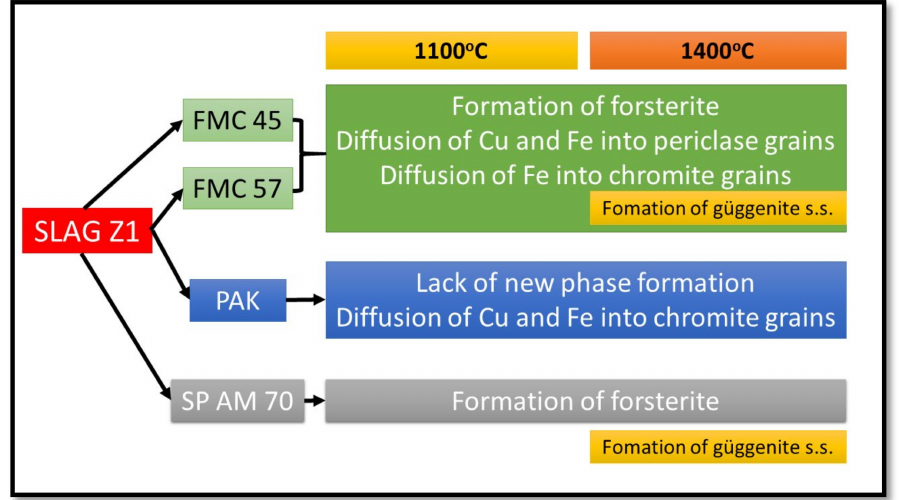
Figure 11. The main mechanisms of the corrosion interaction between refractory raw materials and slag Z1 at 1100 ◦ C and 1400 ◦